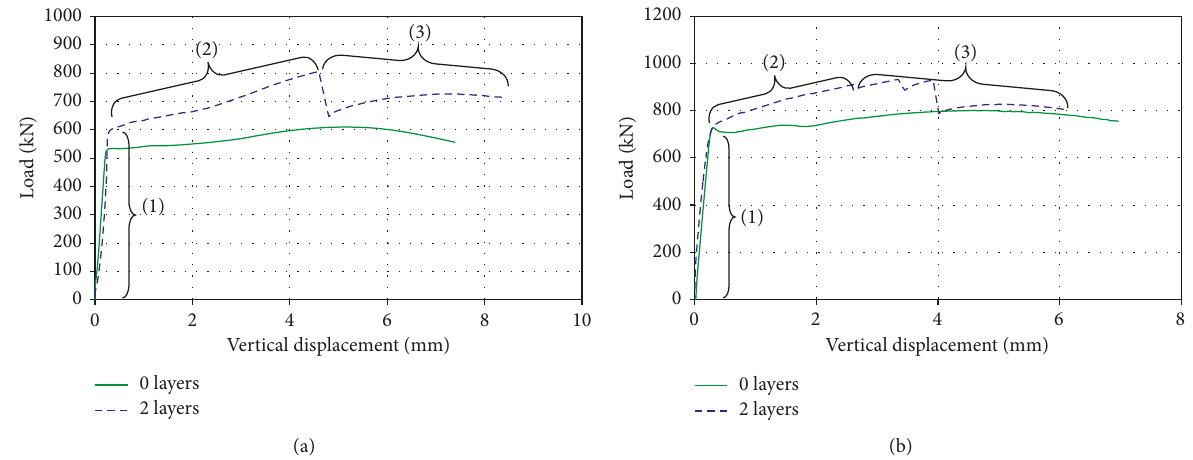
Figure 7: Load-deflection curves and mechanical behavior of unstrengthened and strengthened configurations. (a) Series I. (b) Series